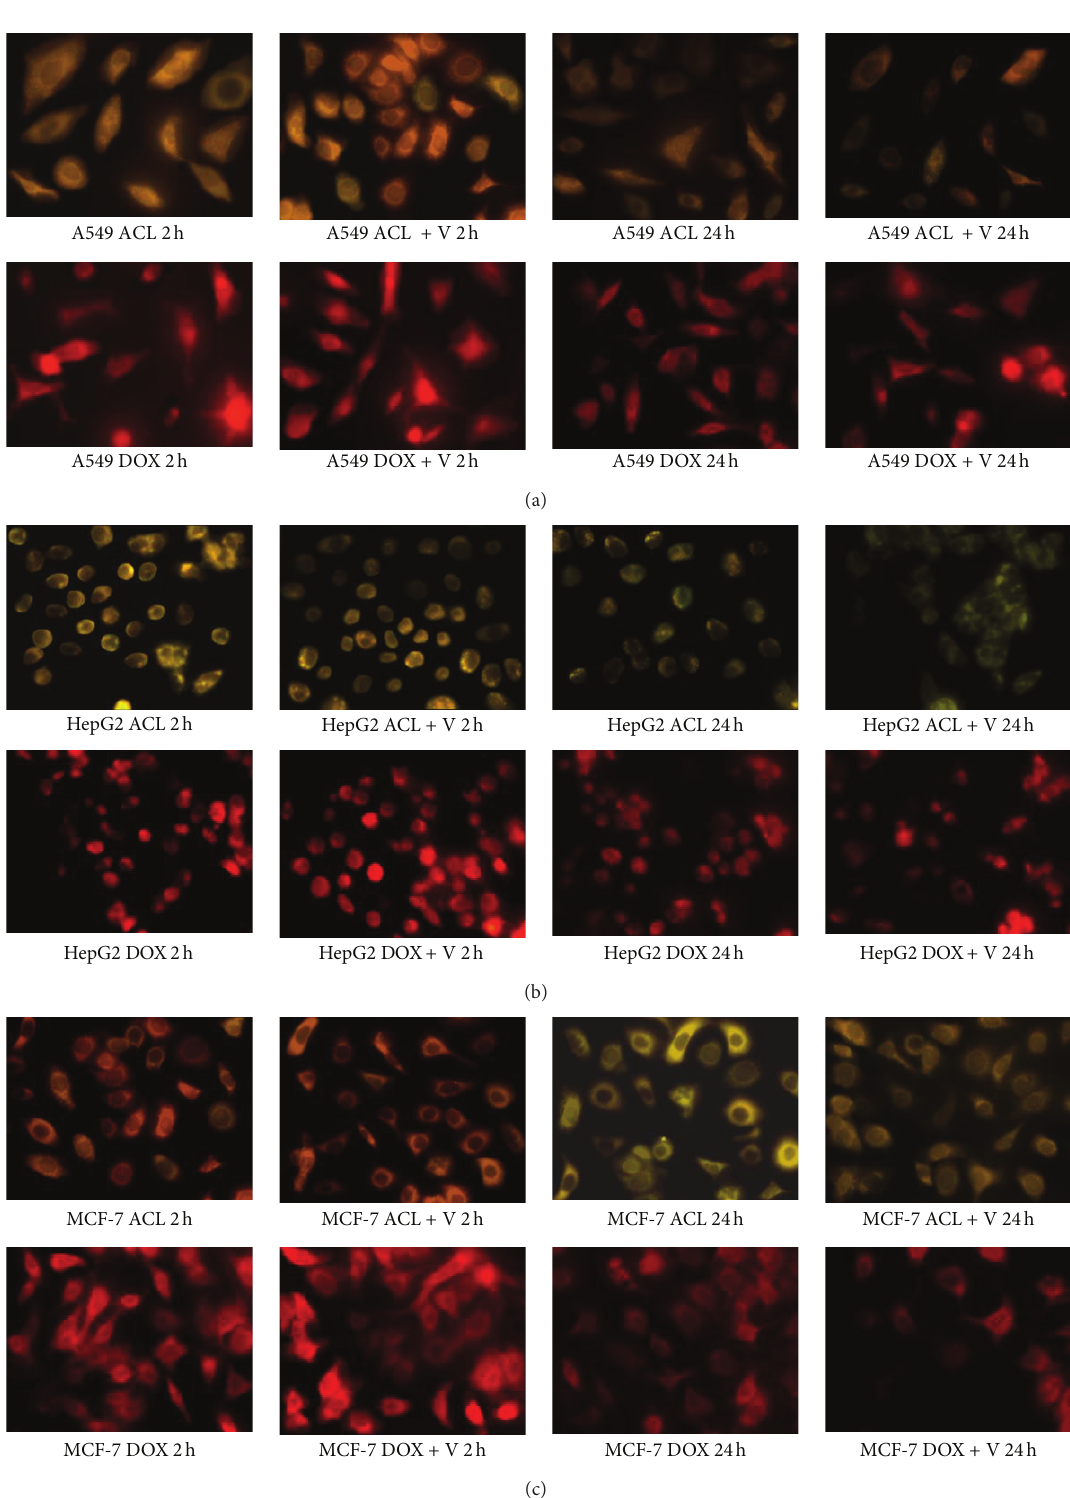
Figure 3: Intracellular DOX and ACL accumulation and their distribution in (a) A549, (b) HepG2, and (c) MCF-7 cell lines. The cells were incubated with IC 50 of each anthracycline for 2h, or, after 2 h incubation with the drugs, the medium was removed and the cells were cultured in fresh medium for another 24 h. In the experiments with Verapamil the cells were preincubated for 30 min at 37 ∘ C and then incubated with drugs. Fluorescence was monitored using an Olympus IX70, Japan, magnification